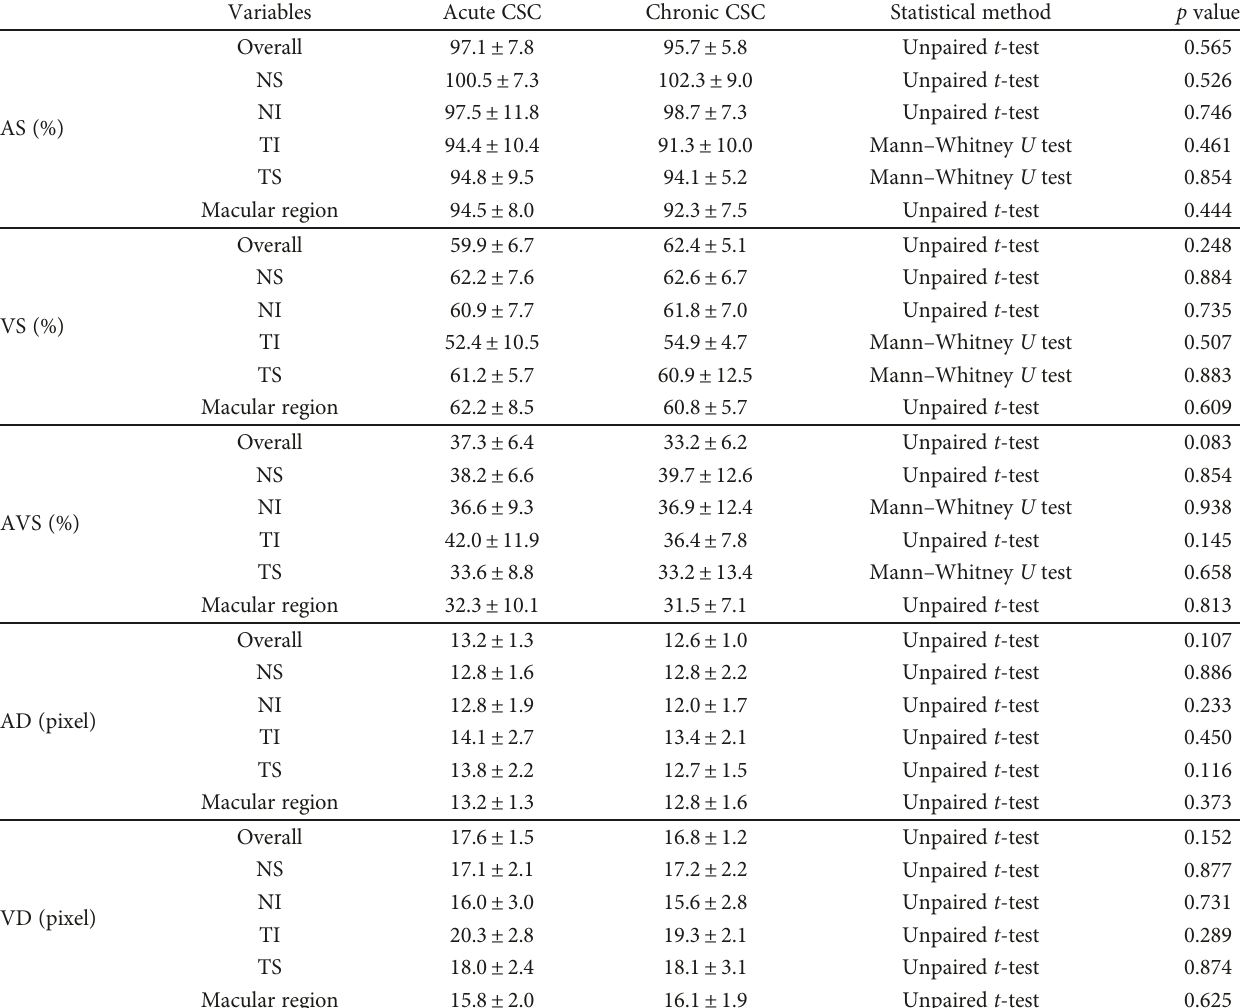
Table 3: Comparison of oxygen saturation and vessel diameter of the a ff ected eyes between acute and chronic CSC